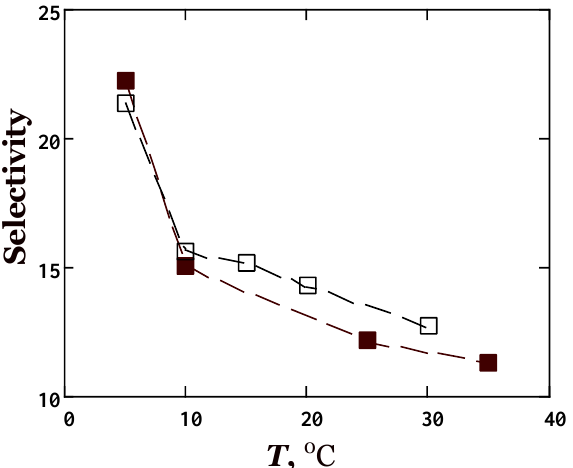
Figure 5. Temperature dependence of n -butane/methane selectivity of poly(tetradecyl methyl siloxane) in the zero pressure limit. The filled symbols represent values obtained by the sorption method, the open symbols show selectivity values determined by the permeation method.